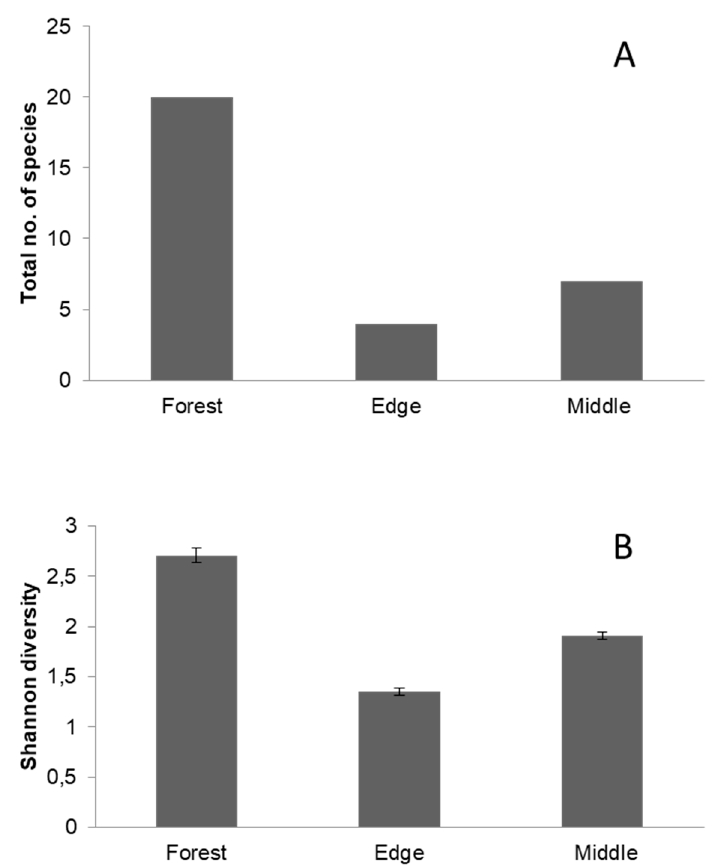
Figure 3. Shows ( A ) total number of mite species and ( B ) Shannon diversity index of mites collected from the Umtamvuna forest and two sites (middle and edge) in the Coffea arabica